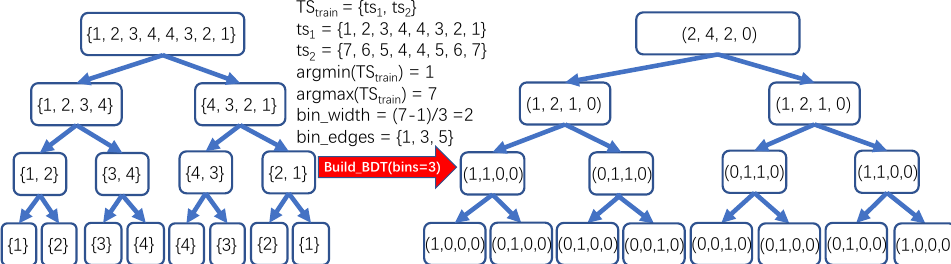
Figure 3. An example for Binary Distribution Tree (BDT) transformation procedure.